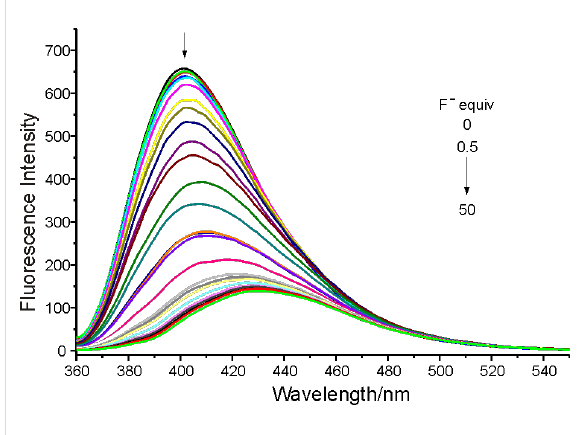
Figure 6: Fluorescence emission changes of 1 (5 μ M) upon the add- ition of TBAF in CH 3 CN (excited at 340 nm). Figure 6 shows the changes of fluorescence emission of 1 upon addition of F − in CH 3 CN where the emission maximum was red-shifted to 432 nm. With increasing F − concentration,